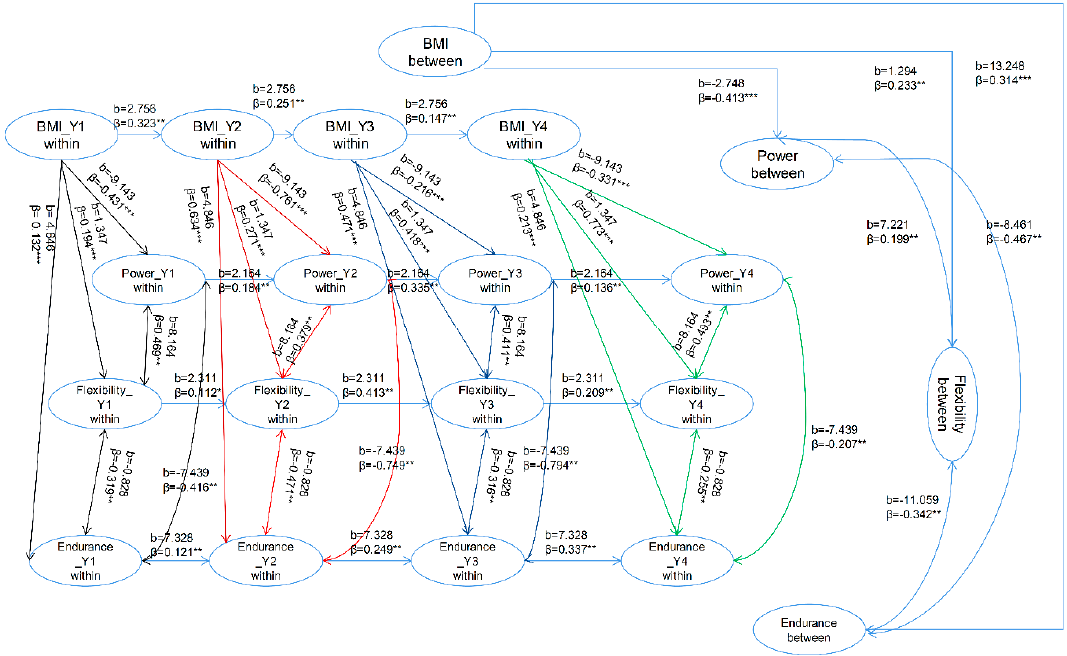
Figure 1. Estimated random intercept panel model of the male samples: simplified and represented above. * p < 0.05; ** p <0.01, *** p <0.001.